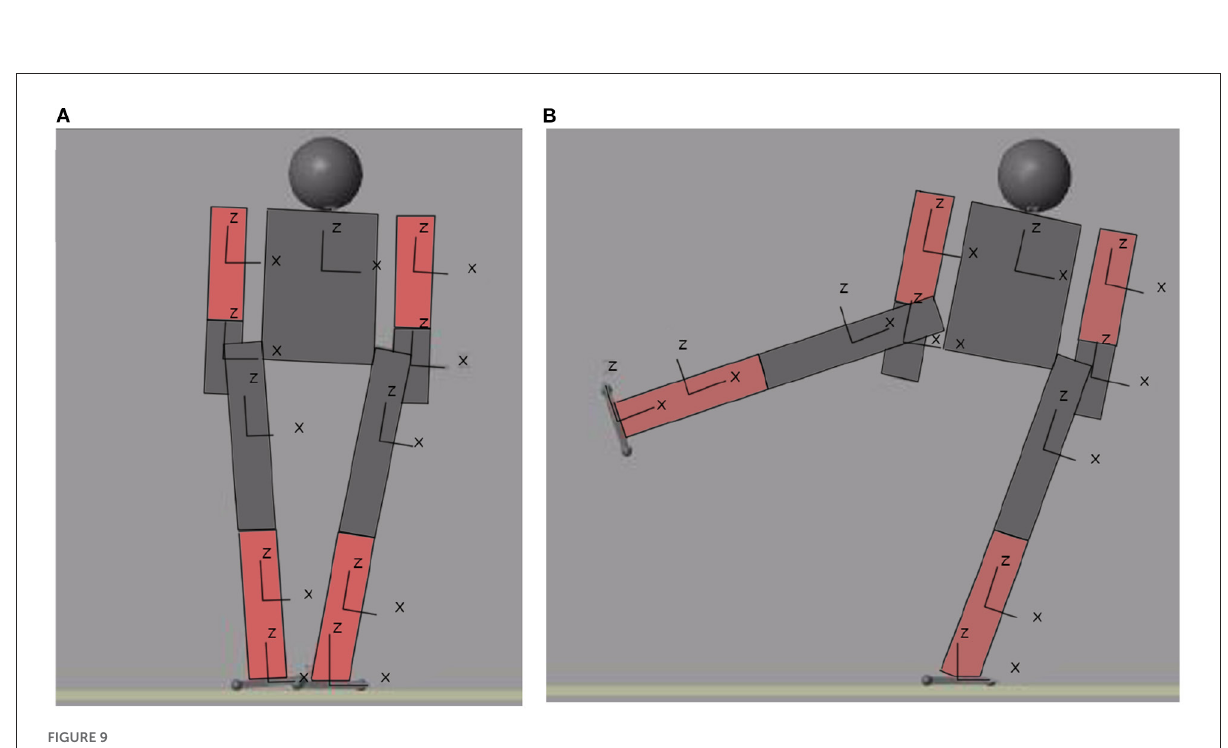
FIGURE9 Initial (A) and final (B) position of the movement